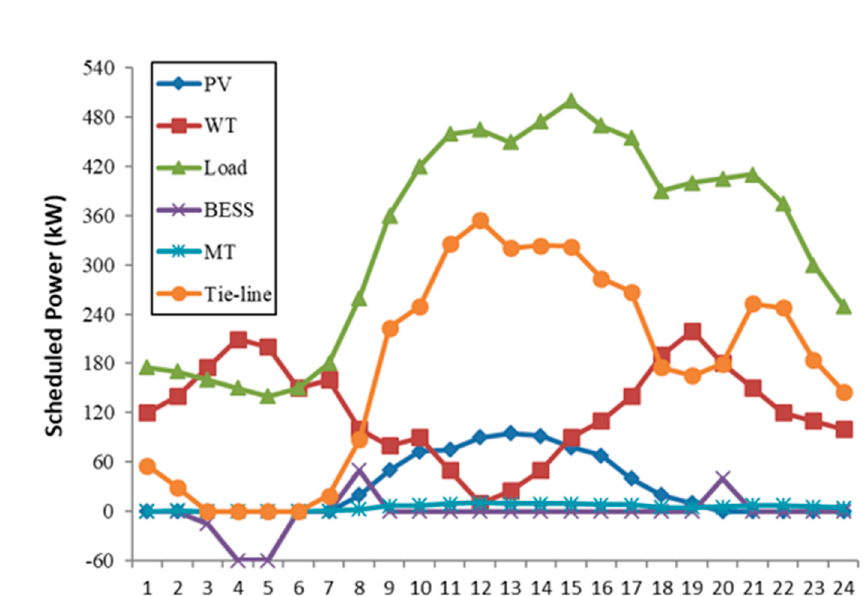
Table 3. Comparison of the operational costs for each case.